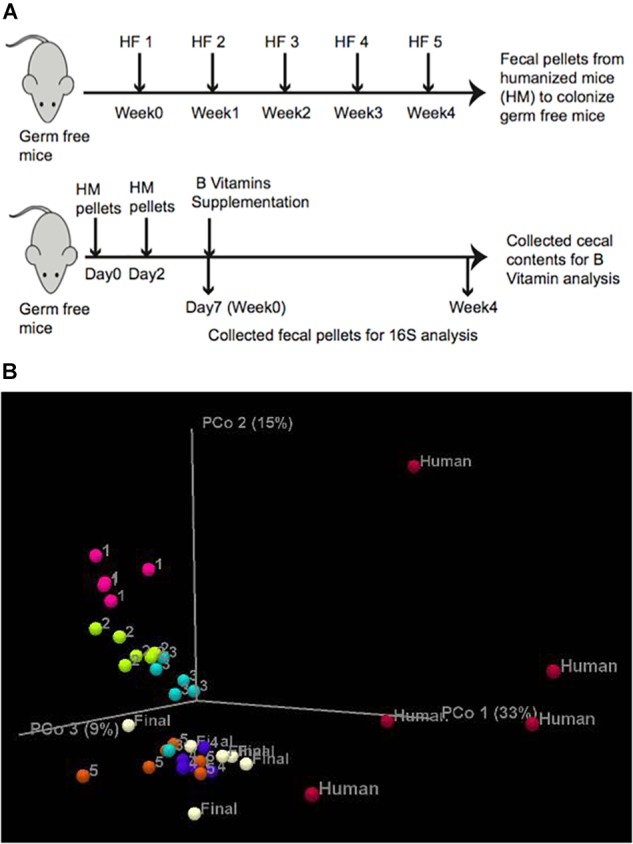
In vivo experimental design. (A) Humanization of germ free mice was carried out by successive gavage with human feces derived from 5 healthy human subjects (HF) at 1 week intervals. After the final gavage, mice were maintained for 4 weeks and fecal pellets from humanized mice (HM) were collected. Lower panel. Germ free mice were gavaged twice with fecal pellets derived from humanized mice at an interval of 2 days. Fecal pellets were collected on Day 7 (controls). B-vitamin supplementation in drinking water (Table 1) was maintained for 4 weeks and fecal pellets were collected for 16S rRNA sequencing and cecal contents were collected for LC/MS measurement of B-vitamins. (B) PCoA analysis of mouse humanization. Unweighted Uni-Frac β-diversity of communities at different stages of humanization.